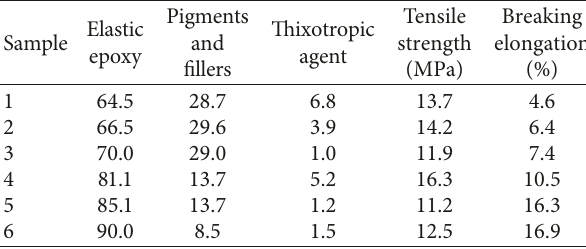
Table 4: Test of samples mixing with pigments and fillers after curing for 7days.